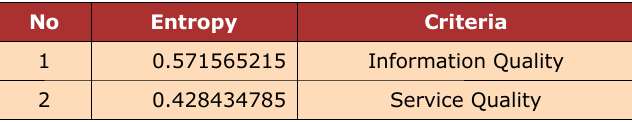
Table 3. Entropy value for criteria